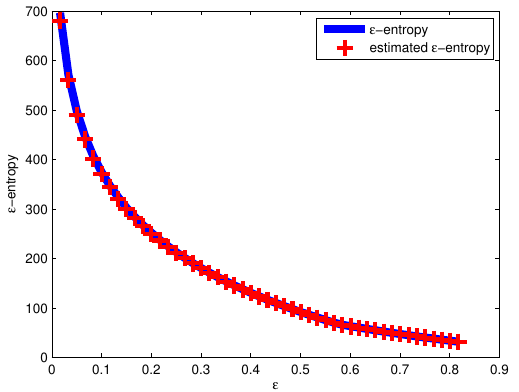
Figure 7: A comparison between the metric entropy esti- mated by the exact singular values and the one estimated by the equation (14) for the frequency diversity when I = [ − 10 , 10] m, Ω o = [ − 1; 1] , M = 3 and Ω k = { π, 6 π } m − 1 .